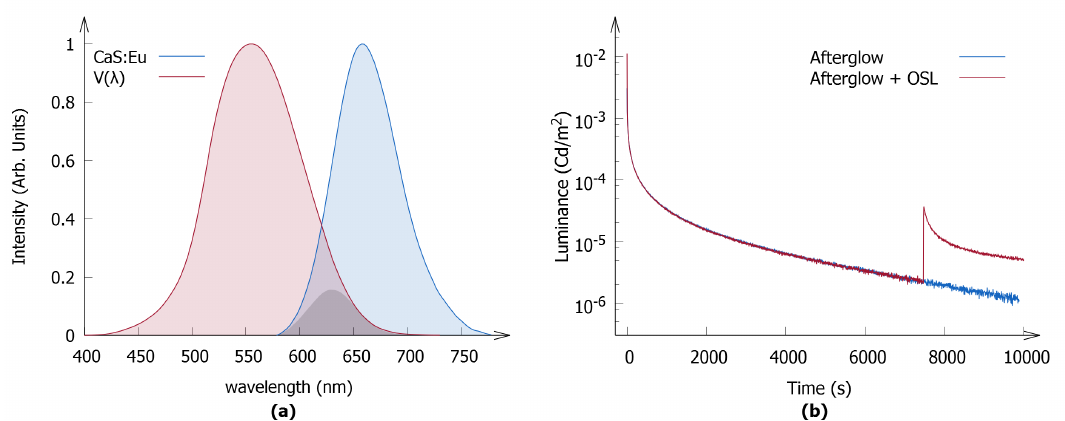
Figure 6. ( a ) The emission spectrum (photon flux) of CaS:Eu is shown in blue. The spectrum was recorded at 300 K under excitation at 475 nm. The photopic eye sensitivity curve is shown in red. The product of both curves is depicted as the shaded gray area; ( b ) Luminance decay profiles of the polymer layer containing 9 mg of the CaS:Eu nanophosphor after excitation with a 475 nm LED. The OSL is clearly visible as a rise in intensity upon continuous irradiation of the sample with infrared light ( λ = 970